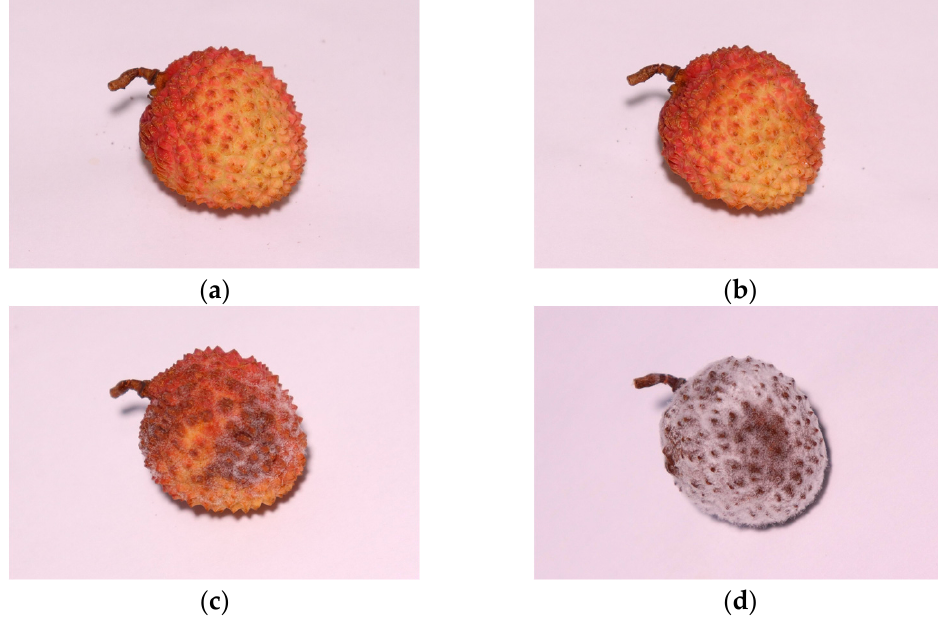
Figure 3. The process of spectral data acquisition.